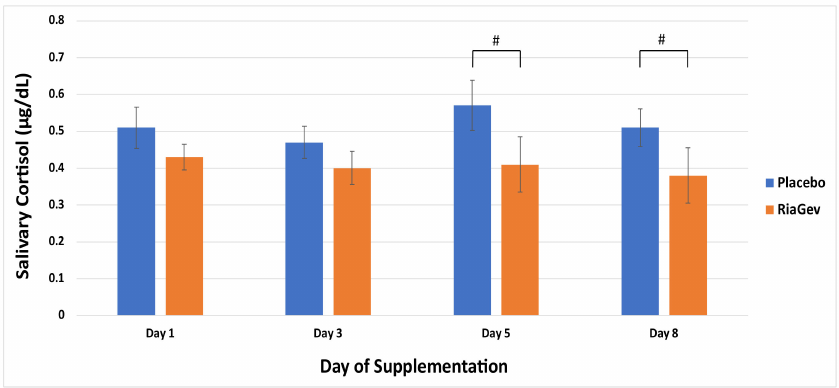
Figure 6. Waking Salivary Cortisol Measurements on Days 1, 3, 5, and 8. Salivary cortisol levels are represented by solid bars with standard errors indicated. A steady and significant decline of waking salivary cortisol from Day 1 baseline levels was observed during the 7-day RiaGev supplementation (orange bars), which contrasted with the higher and fluctuating cortisol levels in the placebo group (blue bars). Significant differences between the groups are marked by # ( p <